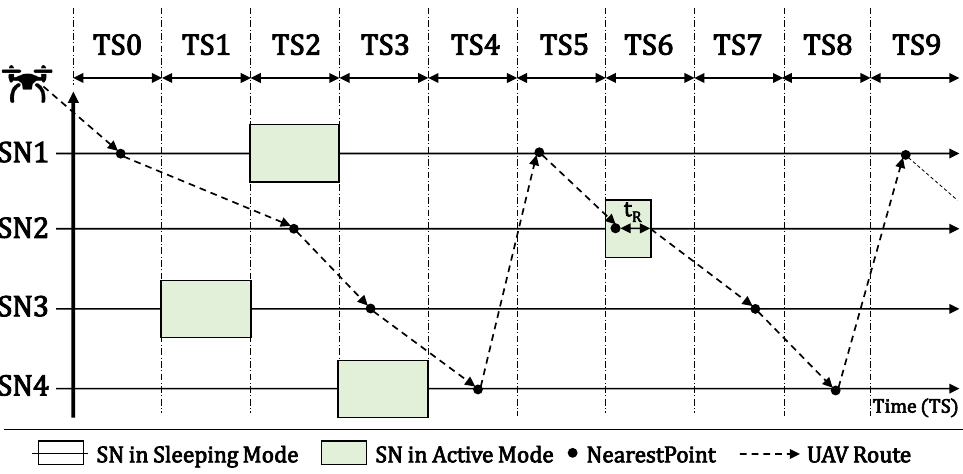
Figure 4. Individual Timeslots